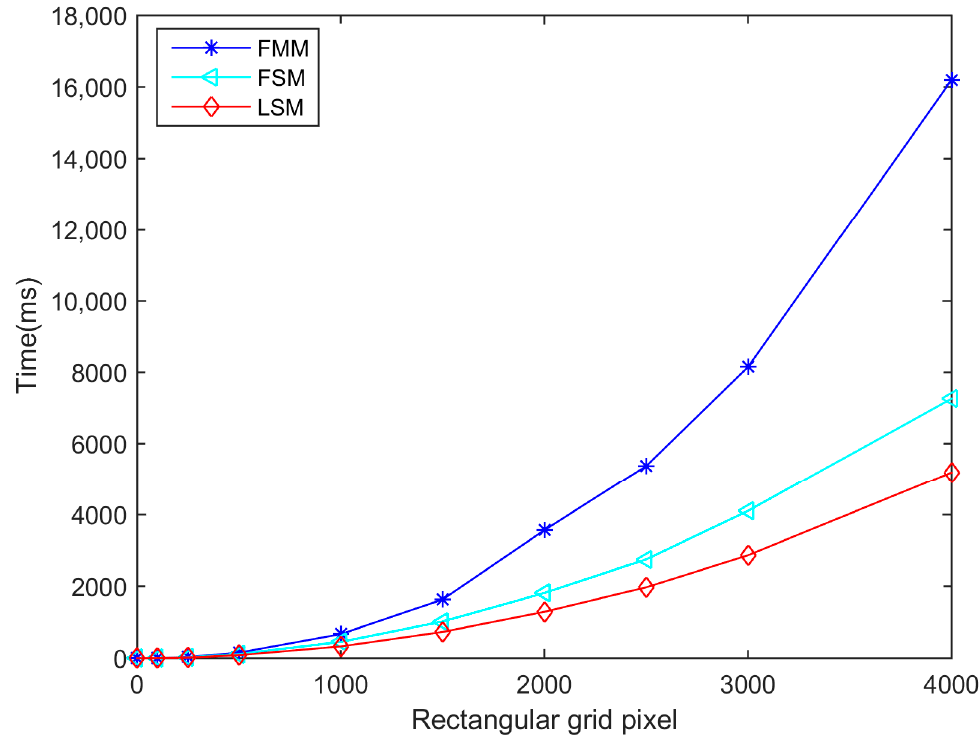
Figure 16. Computation times for the empty map environment using fast marching method (FMM), FSM and